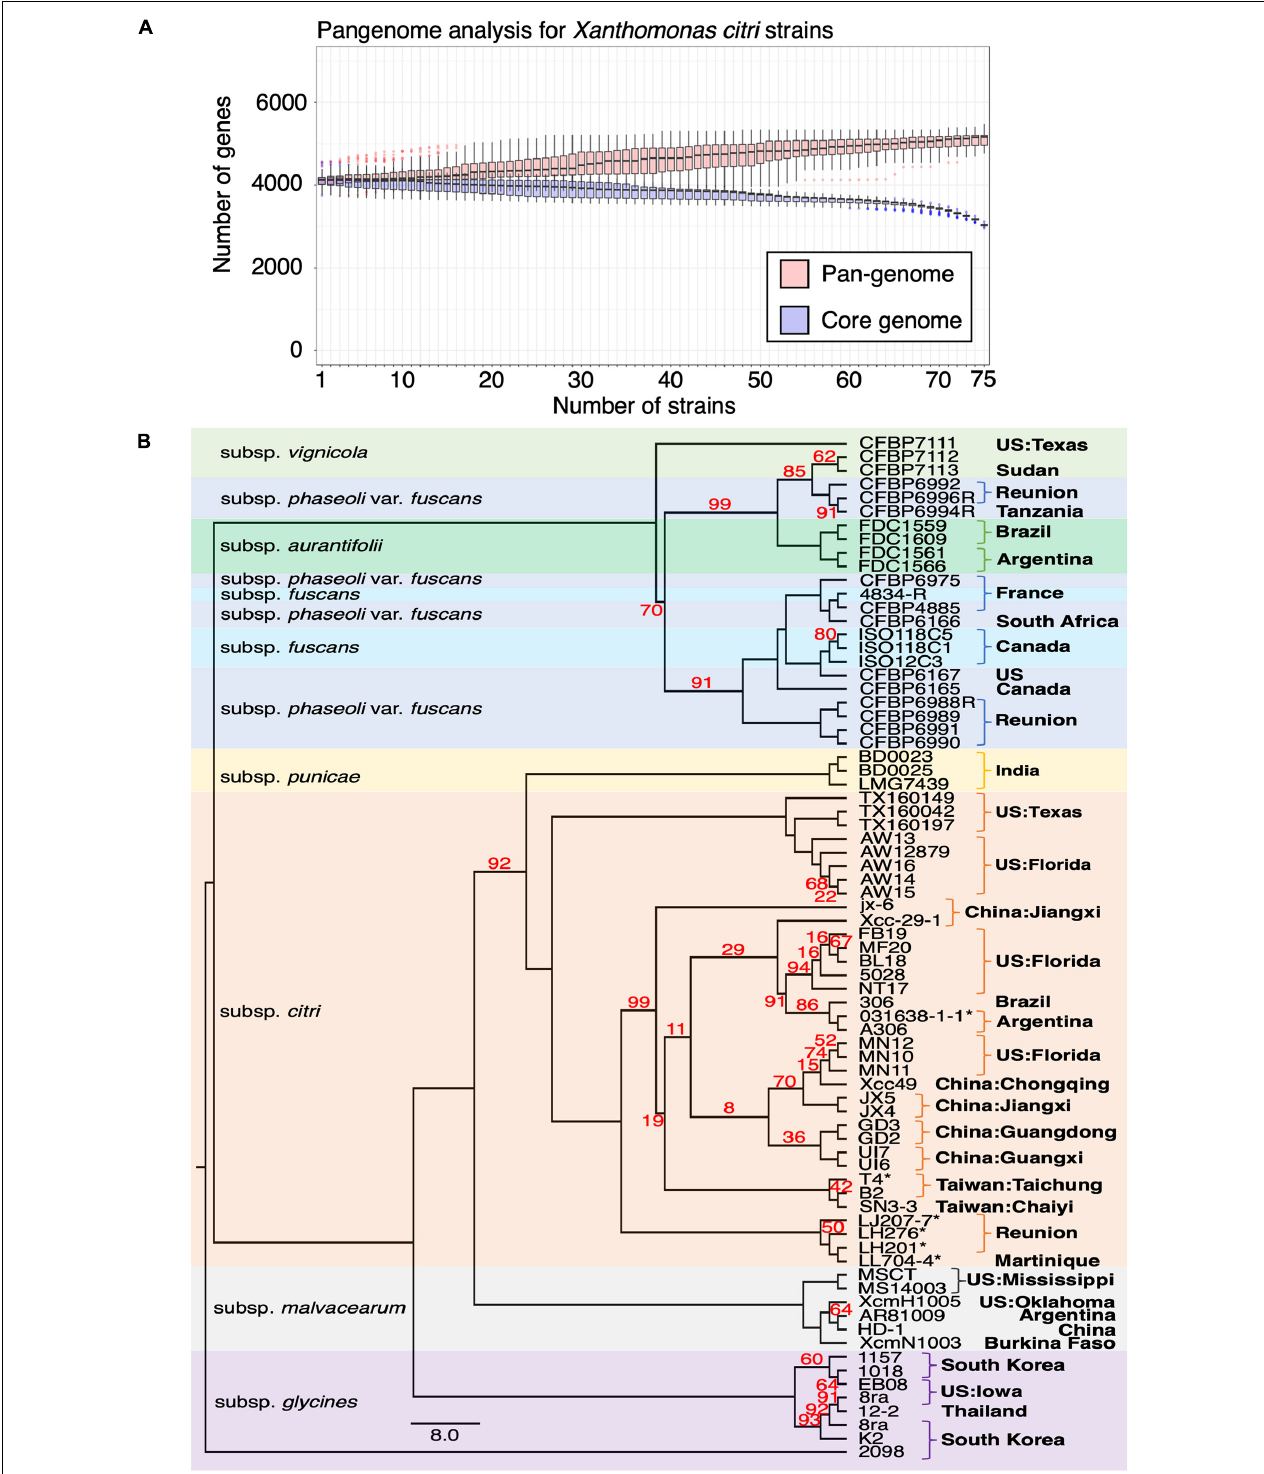
FIGURE 3 | Pangenome analysis of Xanthomonas genomes. (A) Pangenome analysis of 75 X. citri genomes. (B) The core genomes of 75 X. citri sp. strains showed a phylogenetic relationship and shared geographic origins. Maximum likelihood phylogeny based on concatenated sequences of 1,512 core genes. The asterisks (*) indicate copper-resistant strains, and branches with bootstrap value < 100 support are labeled with red numbers.